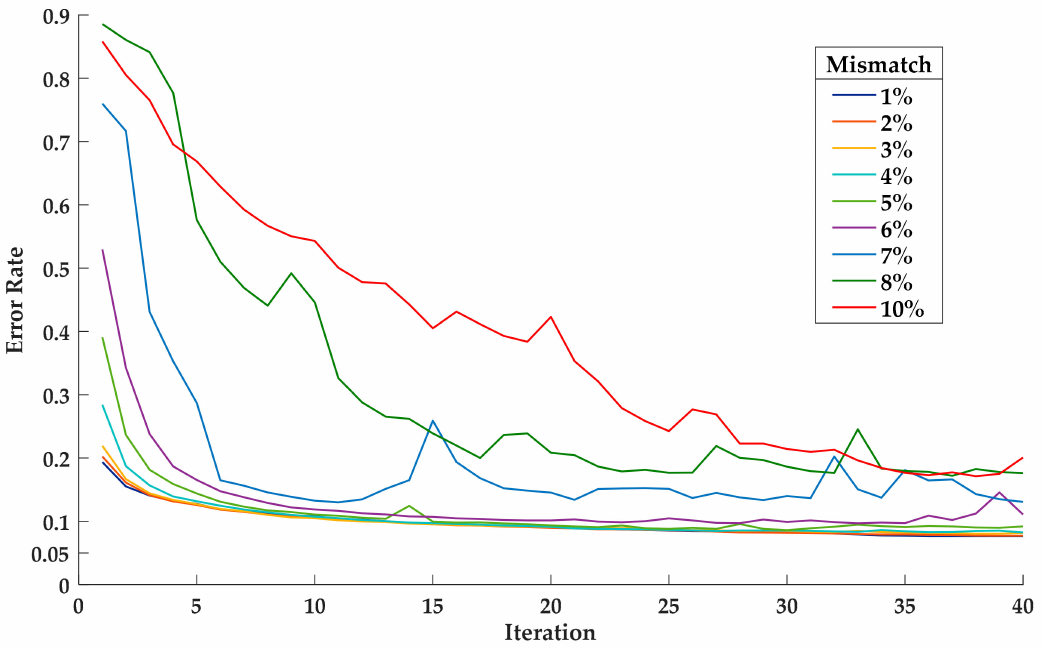
Figure 11. Error rates under different